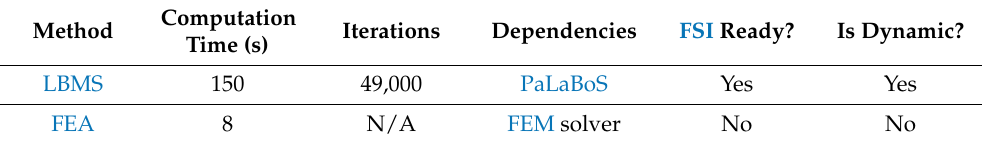
Table 2. Comparison between LBMS and standard FEA methods to compute a solid static equilibrium. Because LBMS method is intrinsically dynamic, results are not competitive for static studies. Computation Iterations Dependencies FSI Ready? Is Dynamic? Method Time (s) LBMS 150 49,000 PaLaBoS Yes Yes FEA 8 N/A FEM solver No